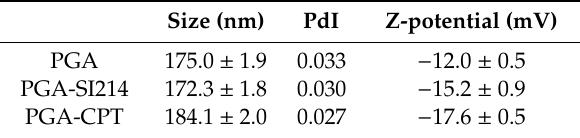
Table 1. Size distribution, polydispersity index, and zeta potential data of the produced nanoparticles